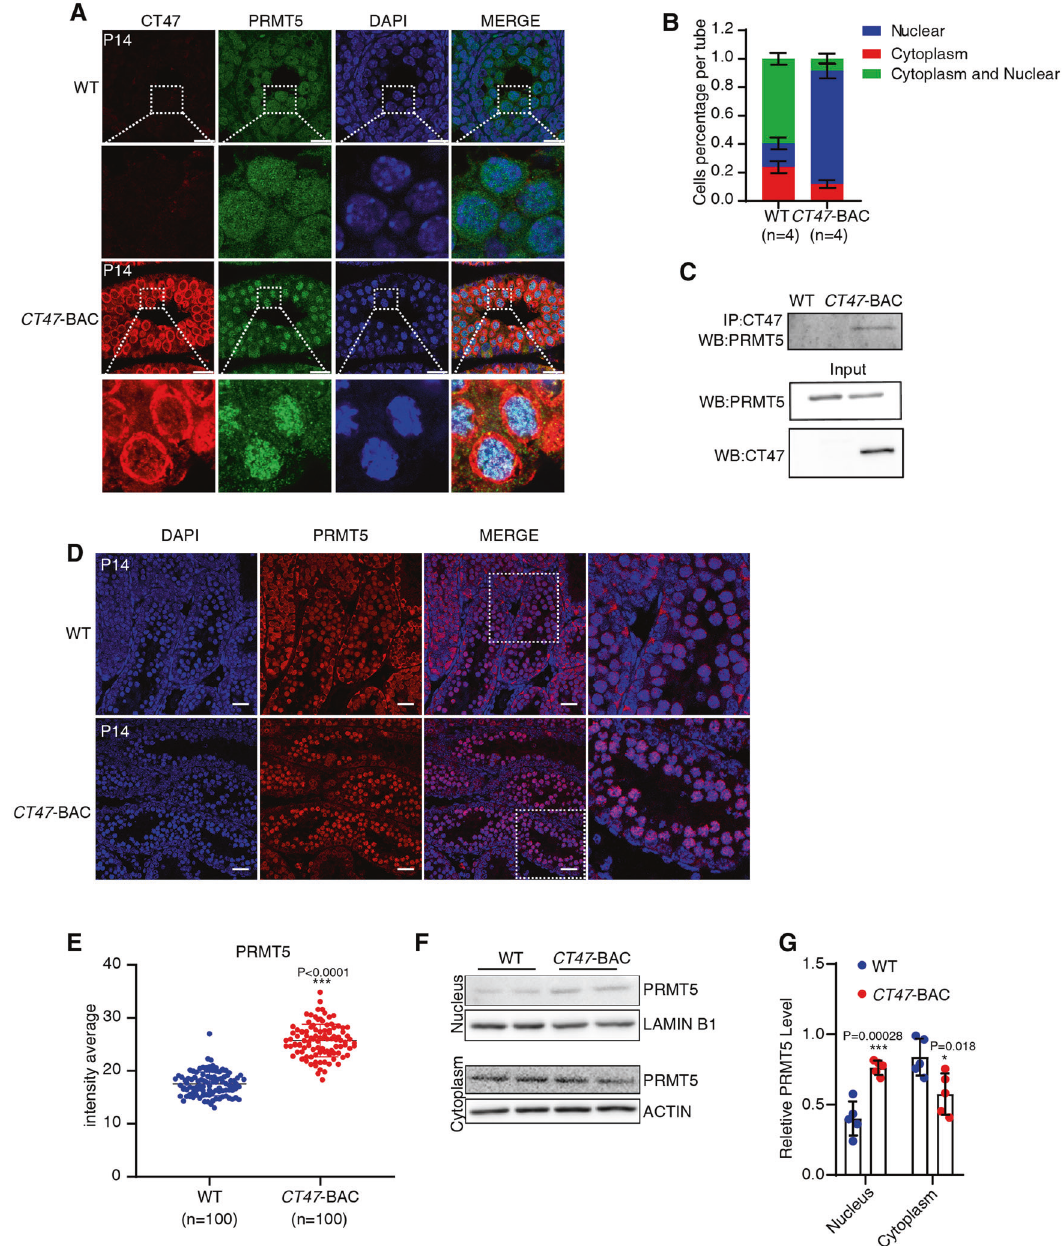
Fig. 4 CT47 promotes the nuclear retention of PRMT5 in leptotene spermatocytes. A Coimmuno fl uorescence staining for PRMT5 (green) and CT47 (red) in P14 WT and CT47 -BAC testes. Nuclei were stained with DAPI. Scale bar = 20 μ m. B Quanti fi cation for cytoplasmic and nuclear localization of PRMT5 per tube in P14 WT and CT47 -BAC mouse testis. The results shown are the mean values ± SD. n = 4 for each group. C Co- immunoprecipitation of CT47 followed by Western blot detection of PRMT5 from P14 WT and CT47 -BAC testes. WB, western blot. D Immuno fl uorescence staining for PRMT5 in P14 WT and CT47 -BAC testes. Scale bar = 30 μ m. Also see Fig. S7. E Quanti fi cation for intensity average for nuclei PRMT5 in P14 WT and CT47 -BAC mouse testis. The results are the mean values ± SD. n = 100 for each group, *** p < 0.001. F , G Cytoplasmic and nuclear fractions of P14 WT and CT47 -BAC testes were separated by an active motif kit. The lysates were subjected to Western blotting. The relative PRMT5 level was measured. The results shown are the mean values ± SD. Student ’ s t test: n = 5 for each group, *** p < 0.001, * p <